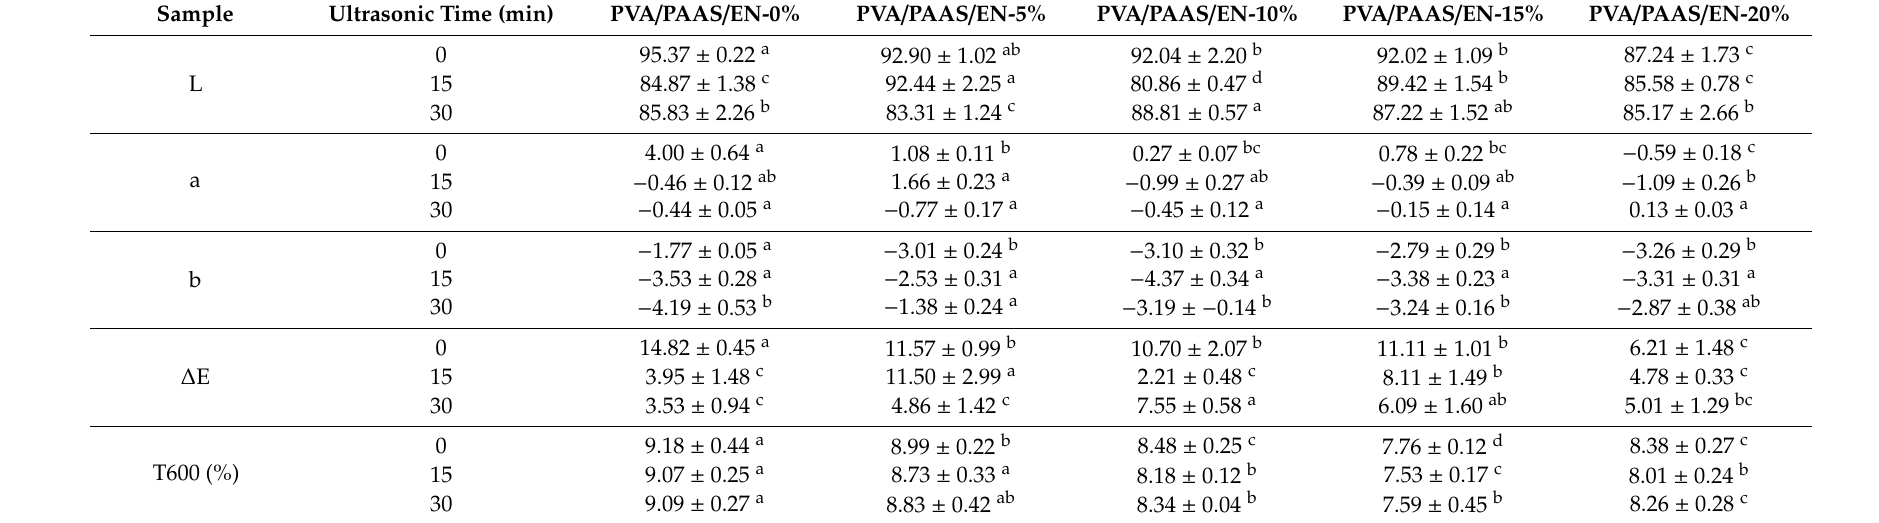
Table 4. Color and light transmittance values of nanofibers under di ff erent ultrasound